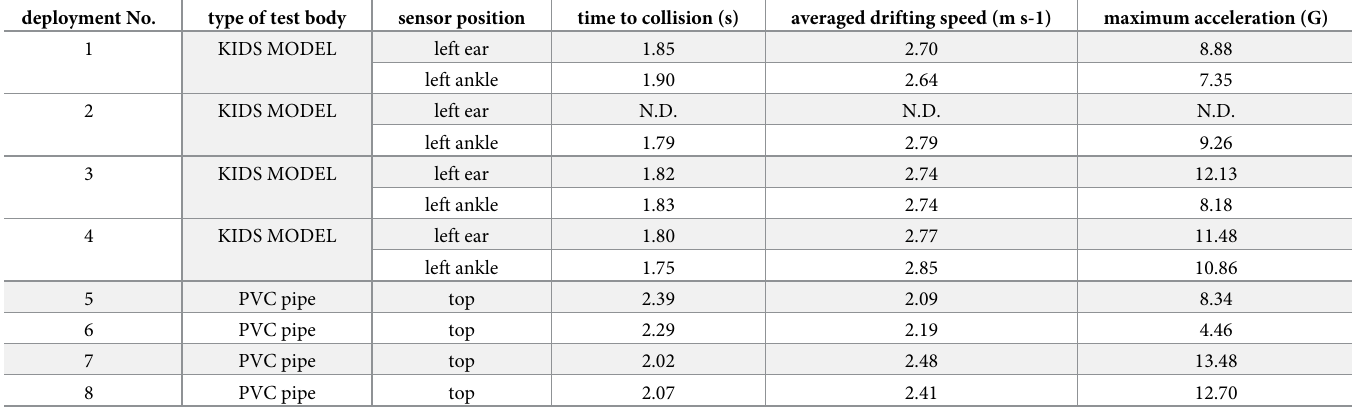
Table 1. Experimental conditions. The time to collision refers to the time elapsed between the arrival of the tsunami wave to the test body and the collision of the test body and concrete block. The values were calculated considering the characteristic variations in the acceleration data. The acceleration data for the left ear of the KM in deployment No. 2 could not be recorded owing to device